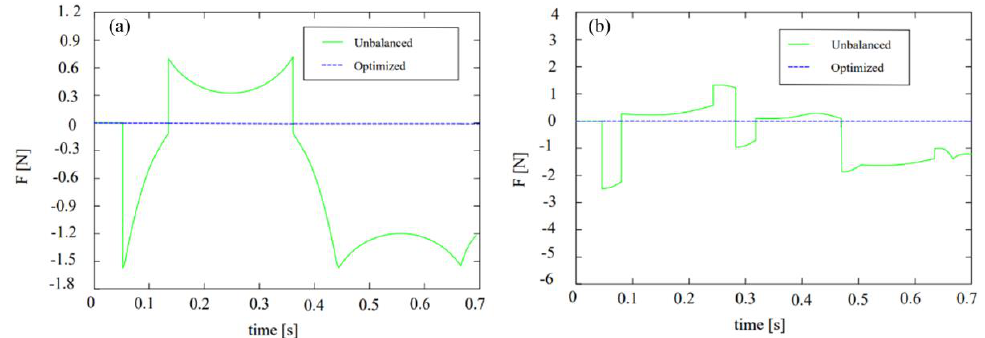
Figure 8. The shaking force of the unbalanced and optimized SPR at ( a ) “low” and ( b ) “high” for trajectory 1.